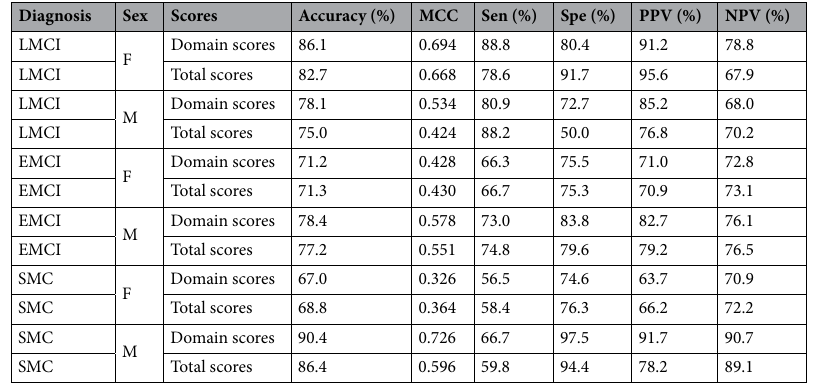
Table 4. Comparing ML models using domain scores or total scores based on 1000